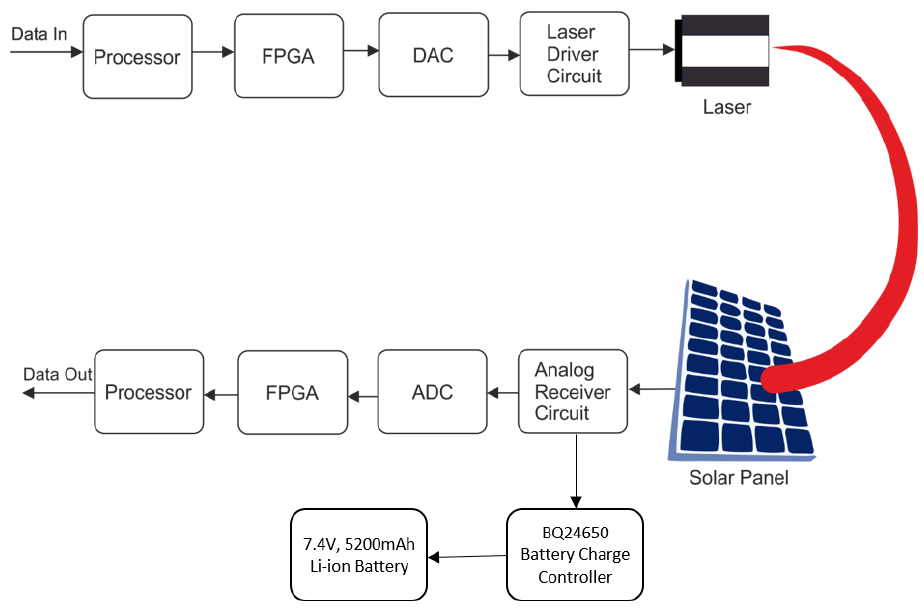
Figure 14. Overall system architecture.